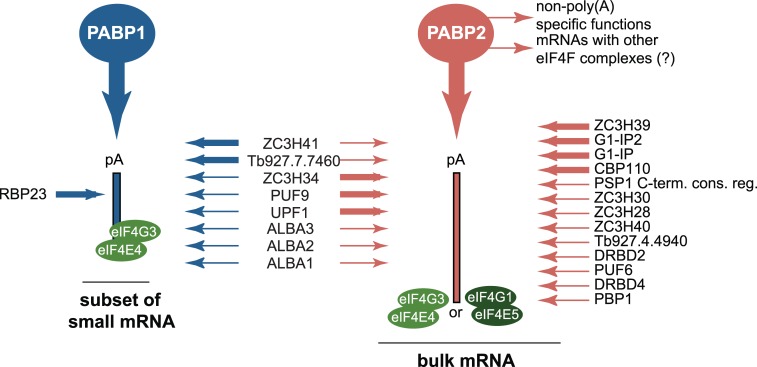
mRNA targets and interacting proteins of PABP1 and PABP2.Presented is a model that is consistent with all available data. PABP1 preferentially binds to a subset of mRNAs of mainly small size, while PABP2 binds to the larger set of bulk mRNAs. The basal translation initiation factors eIF4E4 and eIF4G3 associate with all mRNA targets, while eIF4E5 and eIF4G1 are specific for (a subset of?) PABP2 target mRNAs. All PABP interacting partners are shown with thick lines (>10 fold enrichment) or thin lines (>2 fold enrichment).